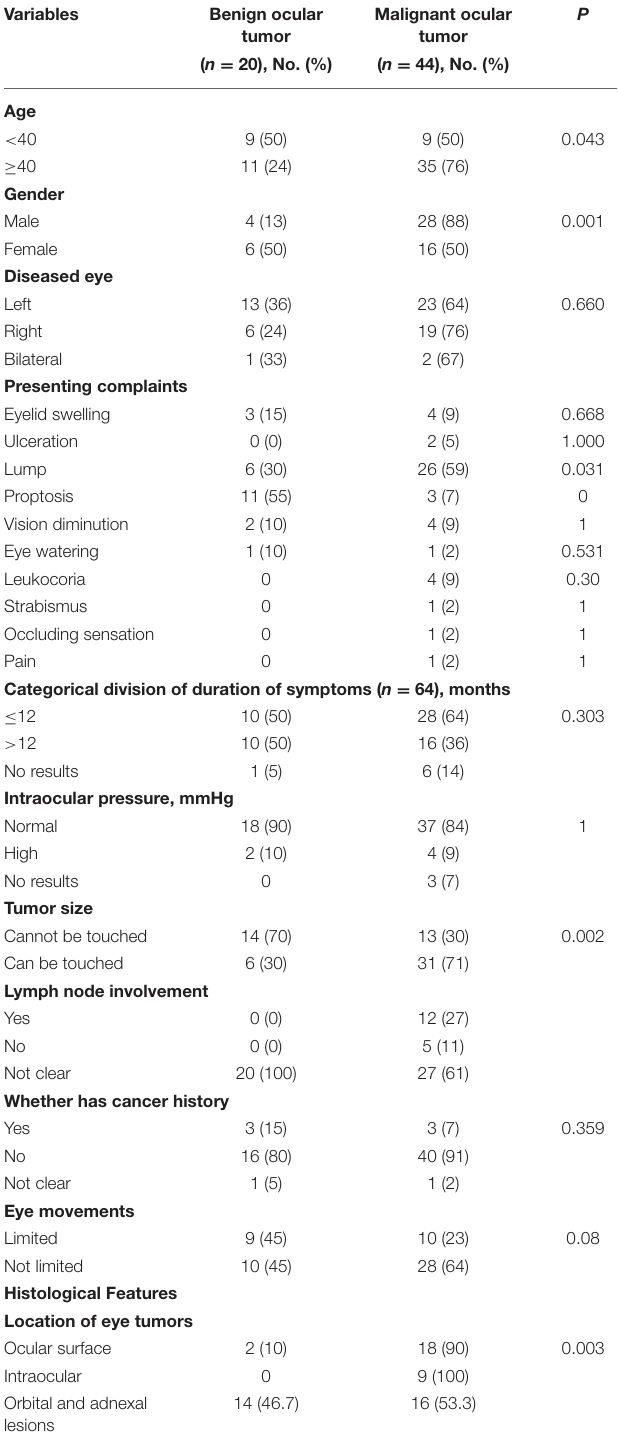
TABLE 4 | Variables of clinical features and demographics predicting the malignant ocular tumors by multivariate